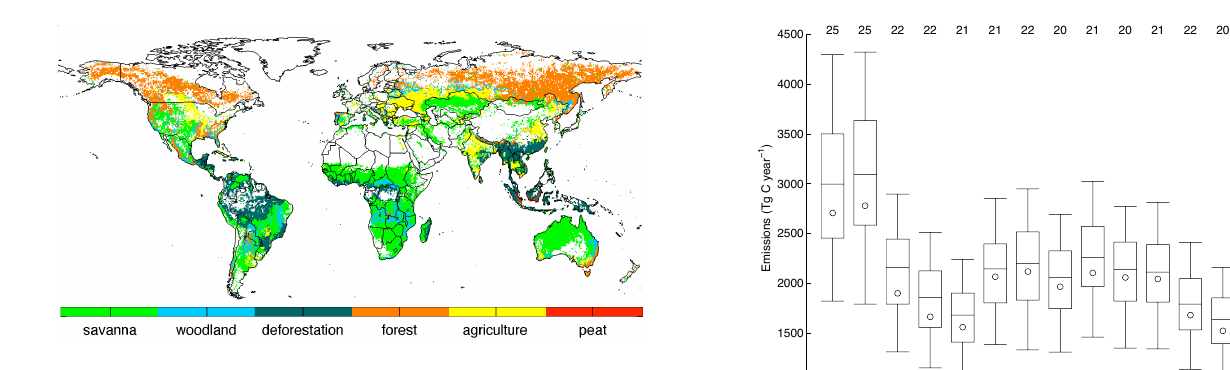
Fig. 12. Percent contribution of different fire types to annual fire emissions in each region. Absolute values are given in Table S1. Average percentages are given for the 2001–2009 MODIS period as well as for the full 1997–2009 time period (in parenthesis).